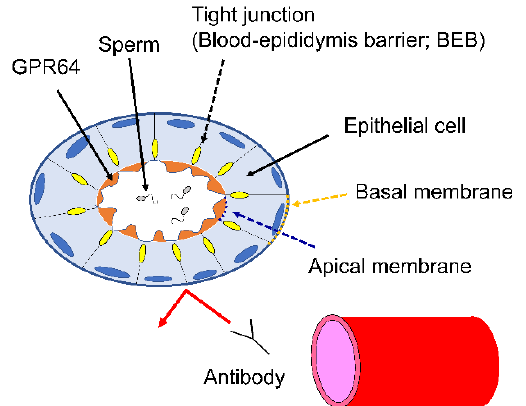
Figure 9. GPR64 on the apical membrane of epithelial cells is protected from the immune system by the blood–epididymis